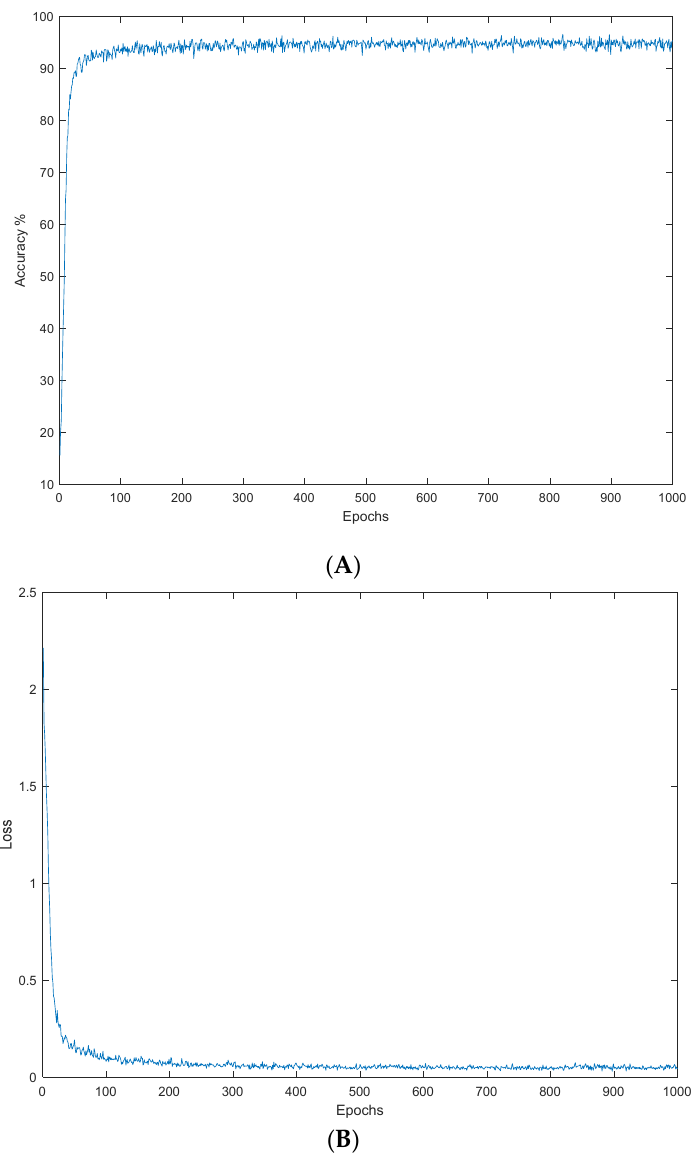
Figure 5. Average Accuracy against epoch ( A ) and average cross-entropy loss against epoch ( B ) for all cross-validation